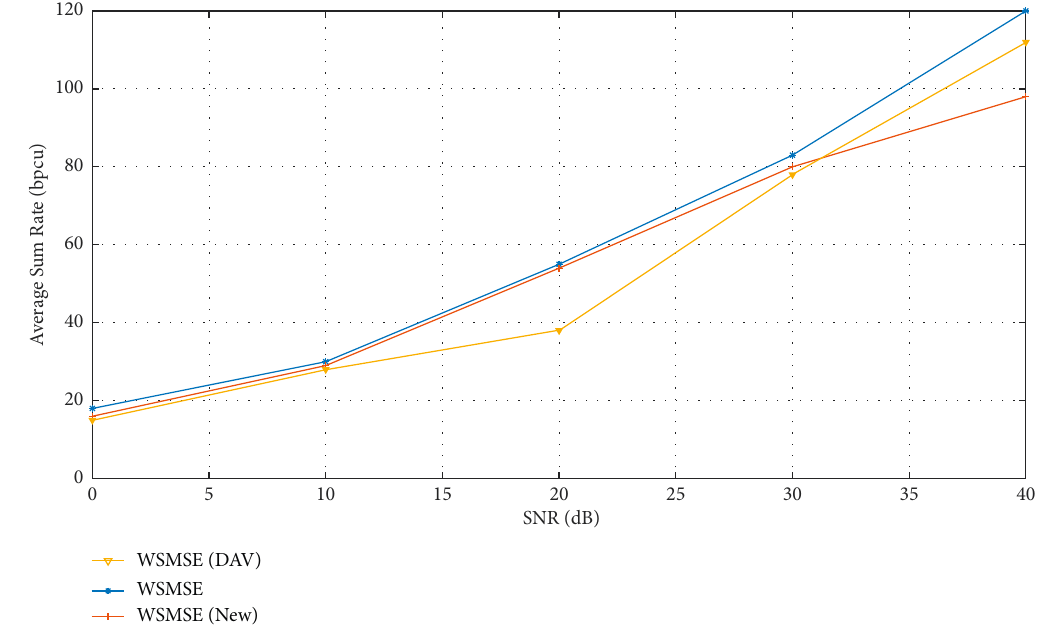
Figure 6: WSR in terms of SNR: C � 3, K � 4, M � 10, and N � 2. Table 1: Simulation parameters and results of Figure